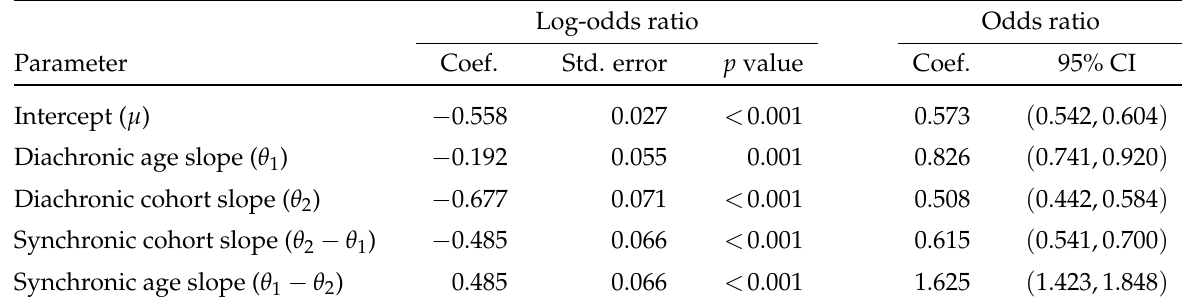
Table 3: Key parameters from diachronic and synchronic L-APC